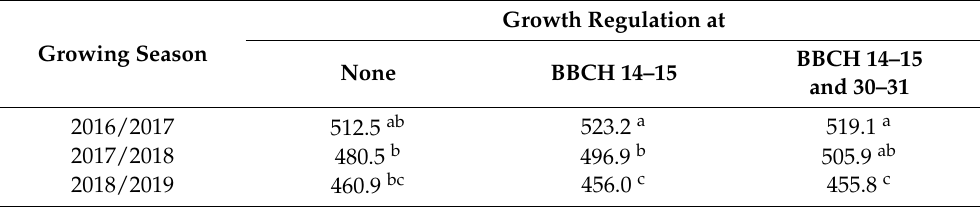
Table 5. The effect of growth regulation on the CF content (g kg − 1 DM) of WOSR seeds (Y ×